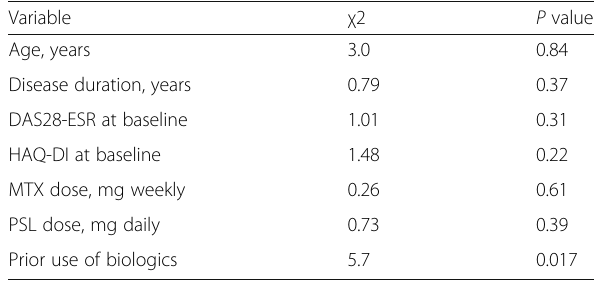
Table 3 Multivariate logistic regression analysis of baseline characteristics associated with sustained